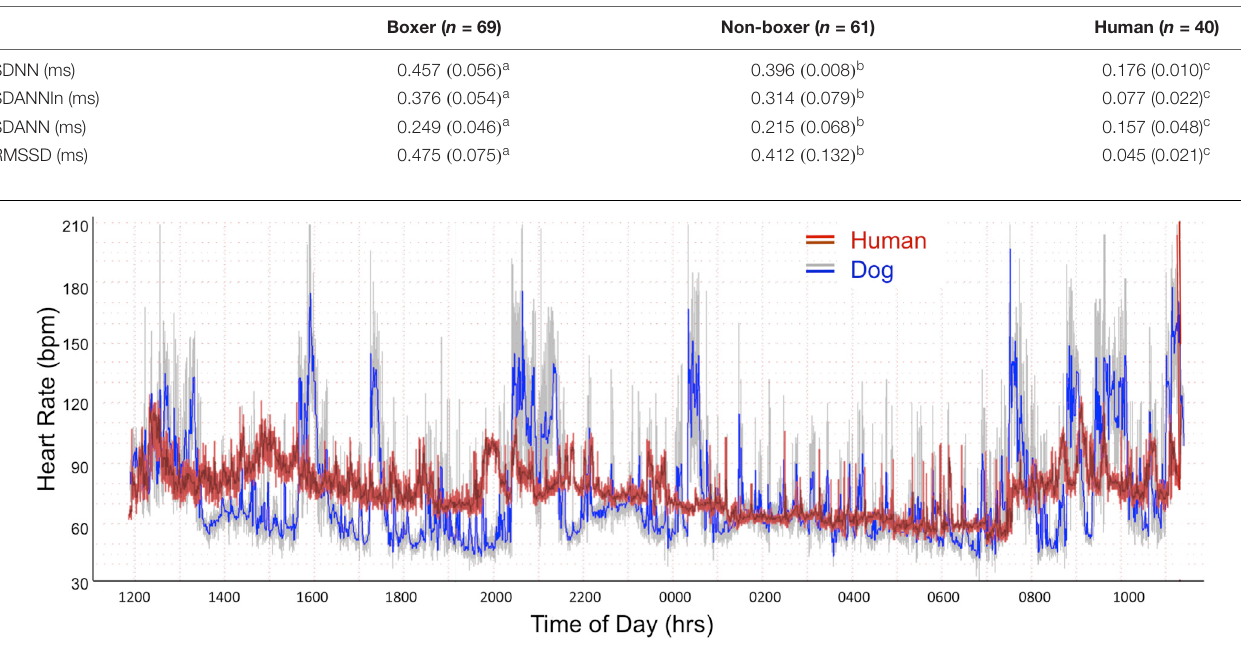
FIGURE 1 | Heart rate tachogram from a human (red/magenta) and dog (gray/blue). The representative patterns exhibited in these two subjects were similar to all. The tachogram shows the heart rate over the course of a 24-h day. The inner magenta (human) and blue (dog) colors indicate the average heart rate as determined by a rolling average of 8 beats. The red (human) and gray (dog) colors indicate the maximum and minimum heart rate during that time. Between the hours of 0100 and 0730 a nocturnal dip (slowing of heart rate) is seen in both the human and dog. In the dog other periods have a similar heart rate slowing associated with sleep as indicated by the diary kept by the owners. The dog has a wider range of heart rates. From the two-dimensional heart rate tachogram the beat-to-beat distribution cannot be determined.